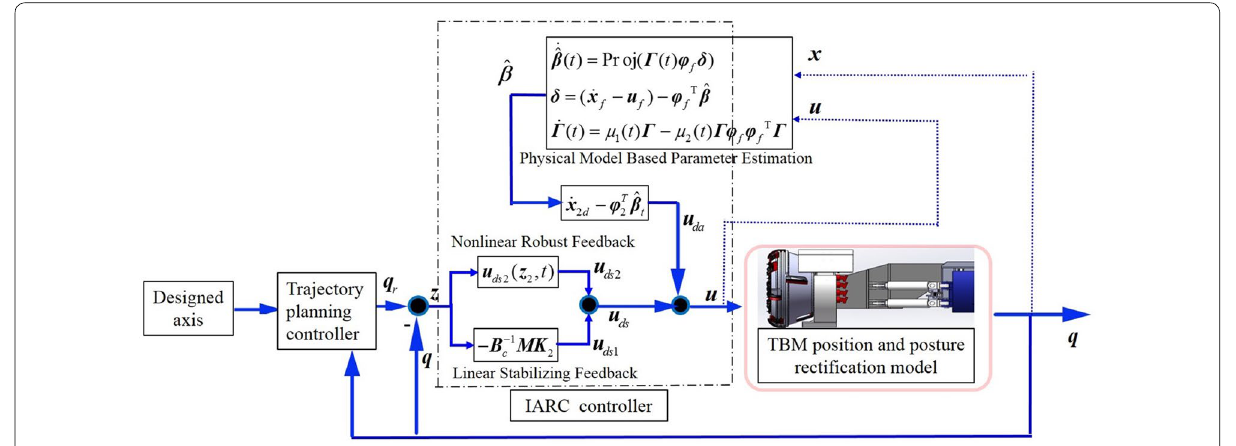
Figure 8 Control block for TBM trajectory tracking control